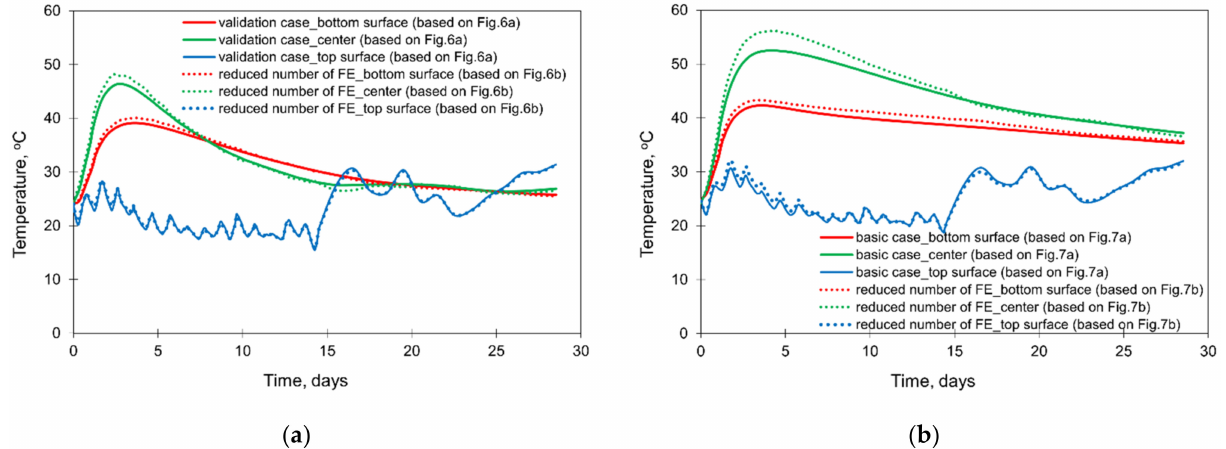
Figure 15. The effect of the different size of FE at the thickness of the slabs on the temperature development in the slab with thicknesses of ( a ) 2 m and ( b ) 4